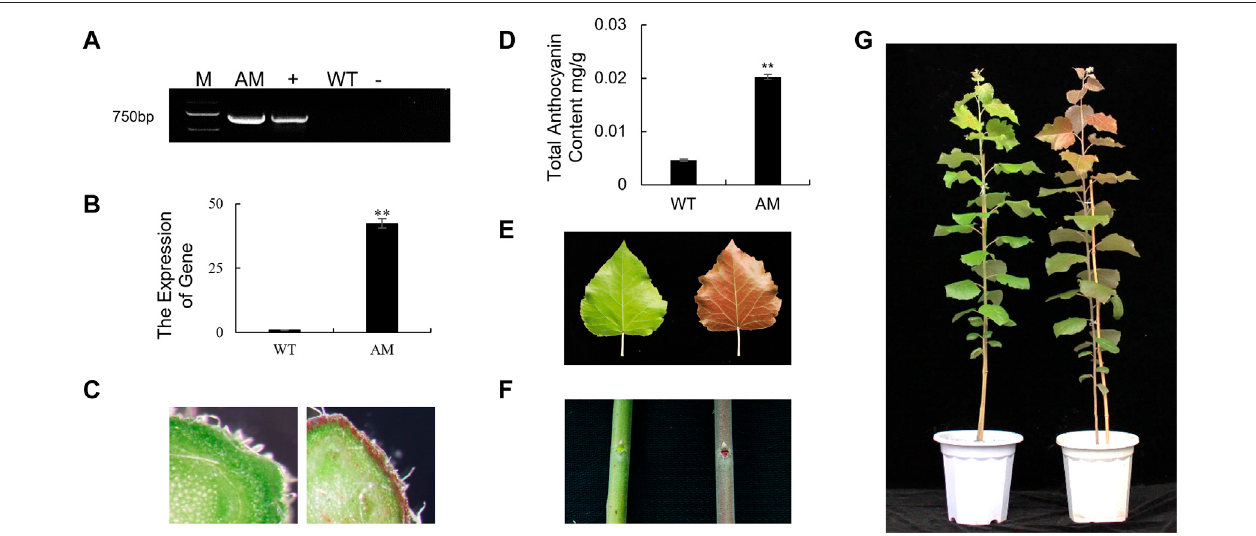
FIGURE 1 | Generation and characterization of AmRosea1 transgenic 84K poplar. The whole picture on the left is wild-type (WT) 84K poplar, and AM on the right is AmRosea1 transgenic material. (A) . Total DNA was extracted from leaf tissue for PCR veri fi cation. M, 2000 bp DNA Marker; AM, AmRosea1 transgenic poplar 84K; +, positive control; WT, wild type poplar 84K; -, negative control. (B) . The expression of AmRosea1 in WT and AM. The stem cross cutting of one-month-old WT and AM (C) . (D) The total anthocyanincontentsofsix-month-oldWTandAMfunctionalleaves.Thephenotypicobservationoffunctionalleaves (E) ,stems (F) ,andthewholeplants (G) ofsix-month- old WT and AM. Error bars represent the SDs from three biological replicates. Statistical differences were determined by a student ’ s t -test (** p < 0.01).